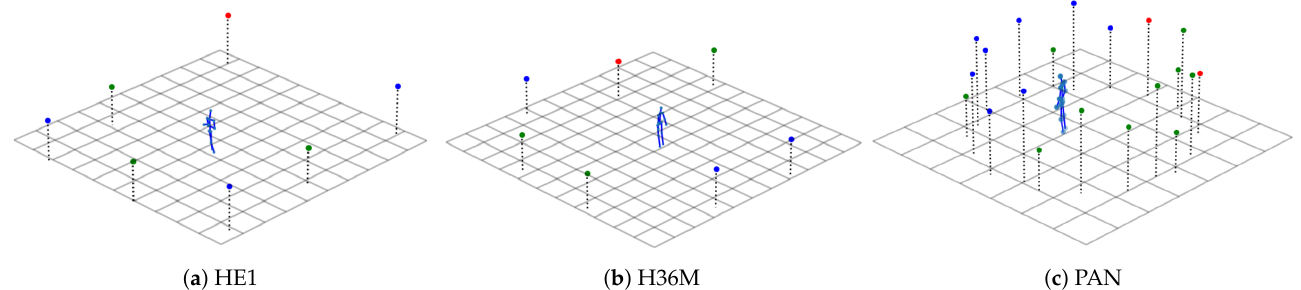
Figure 4. Camera positions and an example pose for the used datasets (grid at z = 0 with 1 meter cell size; blue: reduced training camera set; blue and green: full training camera set; red: test camera set).